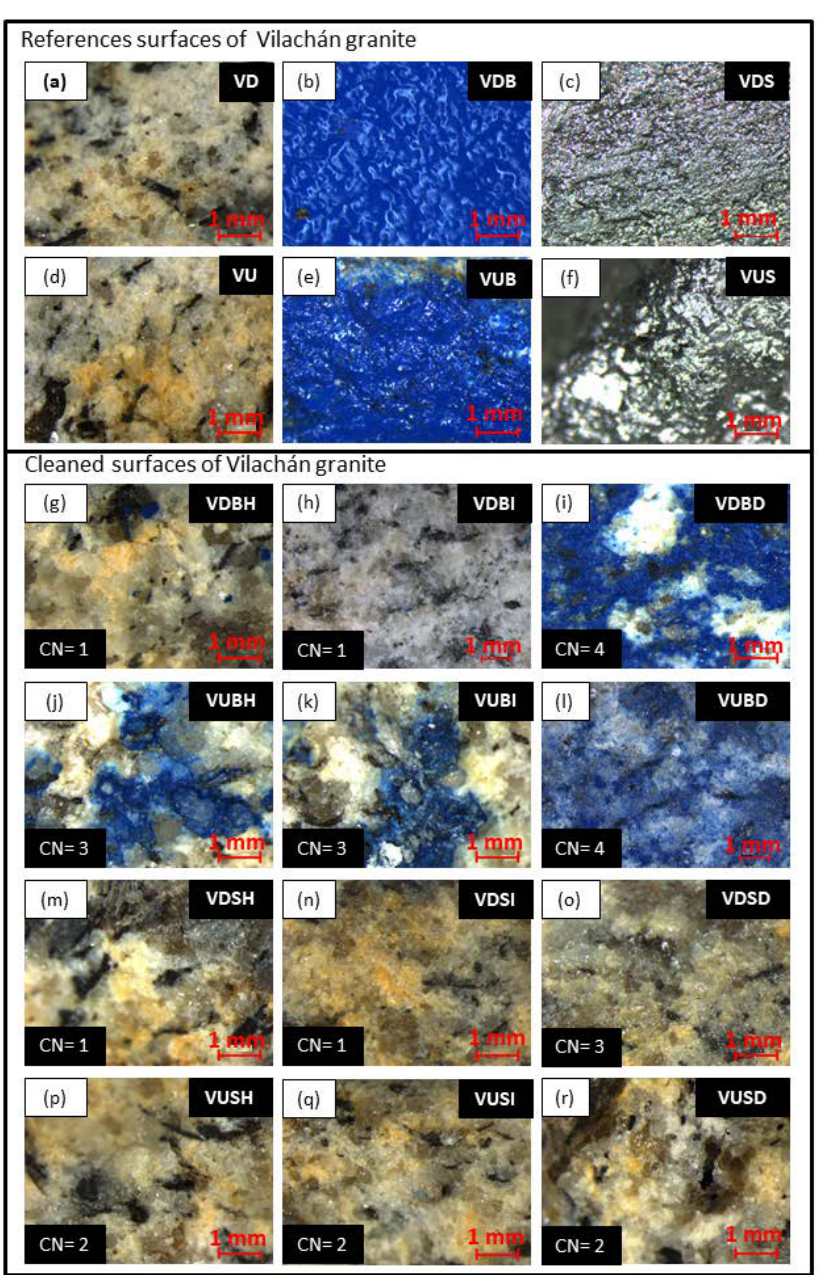
Figure 2. ( a – f ): References surfaces of Vilachán granite (disc-cutting and bush-hammering surfaces, unpainted and painted with blue and silver graffiti paints). ( g – r ): Granite surfaces cleaned of blue ( g – l ) and silver ( m – r ) graffiti paints with Hydrogommage, IBIX, and dry-ice blasting. See Table 1 for samples’ nomenclature.